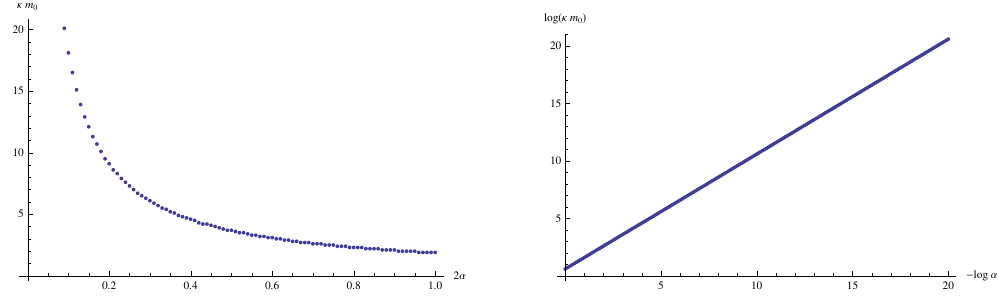
Figure 19 . Relation between m 0 and (cid:11) for a 0 = 10. The surface of the star r (cid:3) s is chosen to be on the neck ( r ( r (cid:3) s ) = a ), but depends on (cid:11) . The density m 0 behaves as m 0 / (cid:20) (cid:0) 1 (cid:11) (cid:0) 1